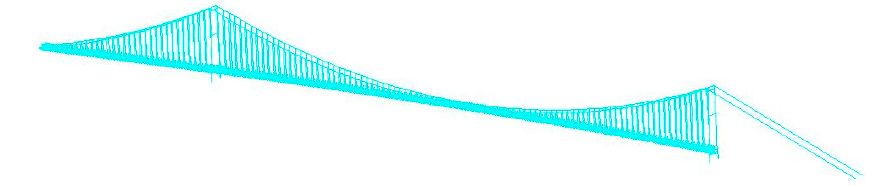
Figure 16. Finite element model of XHM Bridge.